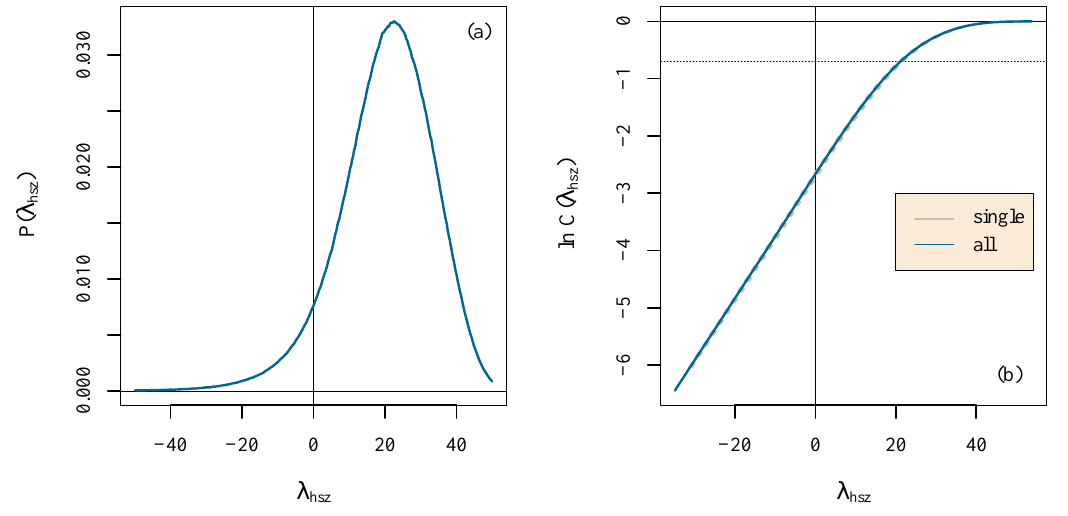
Figure 9. Distribution functions of the Lagrangian vertical heat structure λ hsz for ∆ T = 0.1, constructed from approximately 4 million Lagrangian tracer particles in simulation HC1 ( Pr = 0.1). ( a ) Probability density function constructed from the data for 6 different statistically independent flow realizations. ( b ) Cumulative distribution function. Six dashed lines show distributions constructed from data at different independent flow realizations; the solid line represents a distribution constructed from the data at all 6 times. A dotted line marks the point where C ( λ hsz ) =